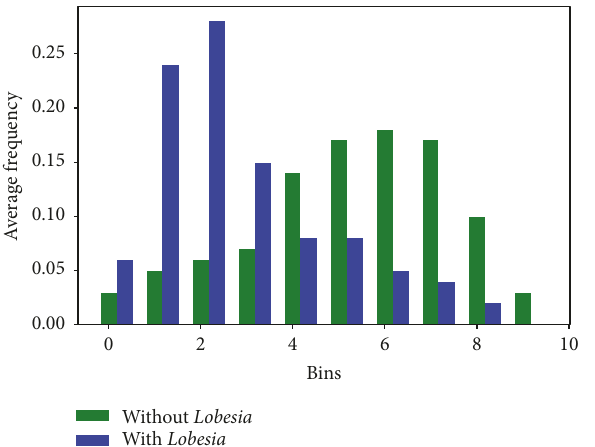
Figure 12: Gray scale descriptor Lobesia versus other elements.